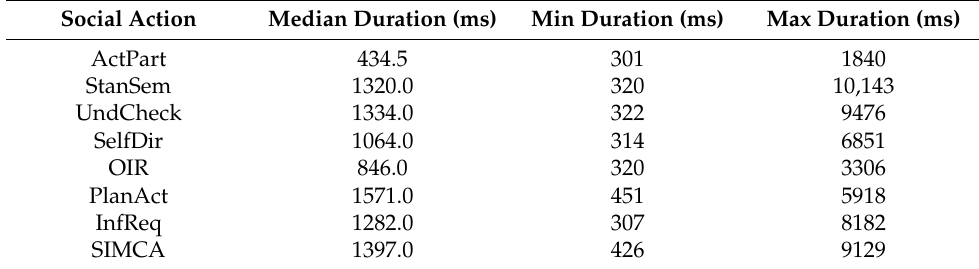
Figure A1. Schematic overview of set-up [image courtesy of Naomi Nota]. Table A1. Distribution of utterance durations per social action.